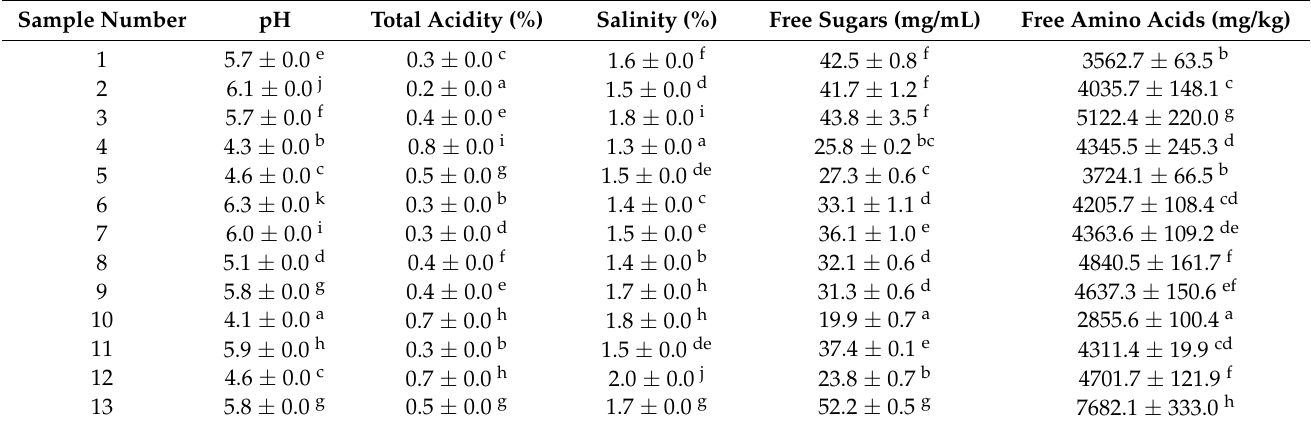
Table 2. Physicochemical properties of the 13 commercial kimchi samples.